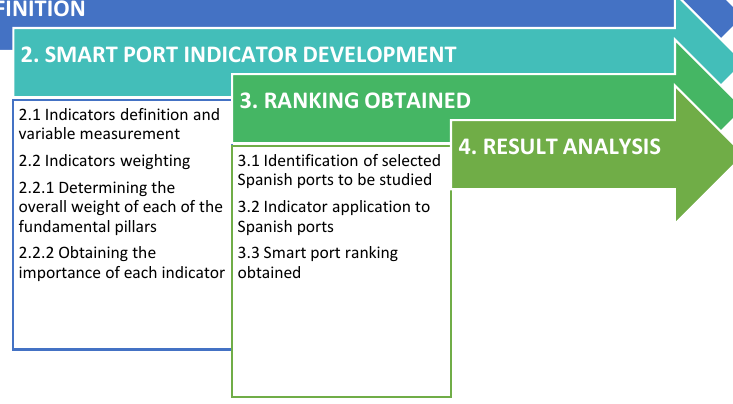
Figure 1. Methodological flowchart.